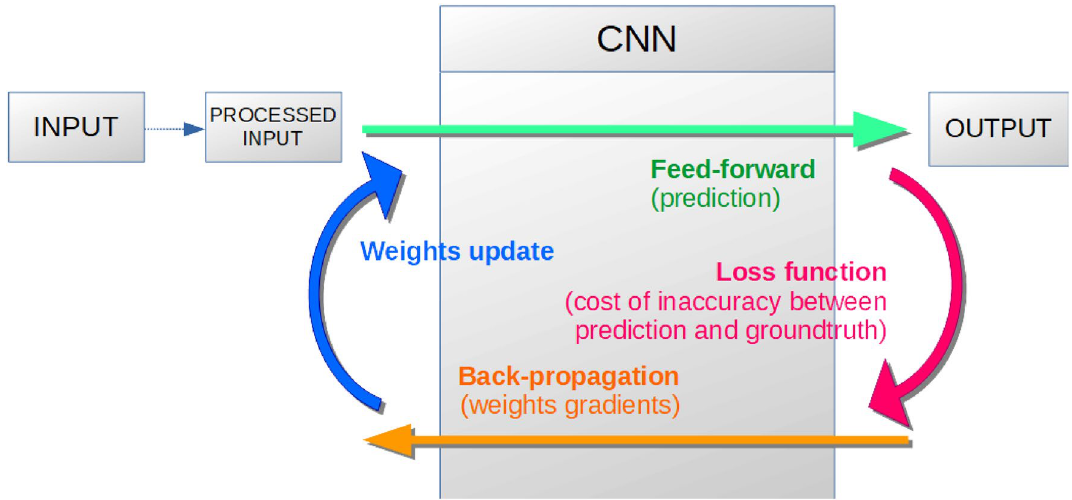
Figure 3. Schematic representation of the pipeline process developed for Glossina identification using the Convolutional Neural Network (CNN)